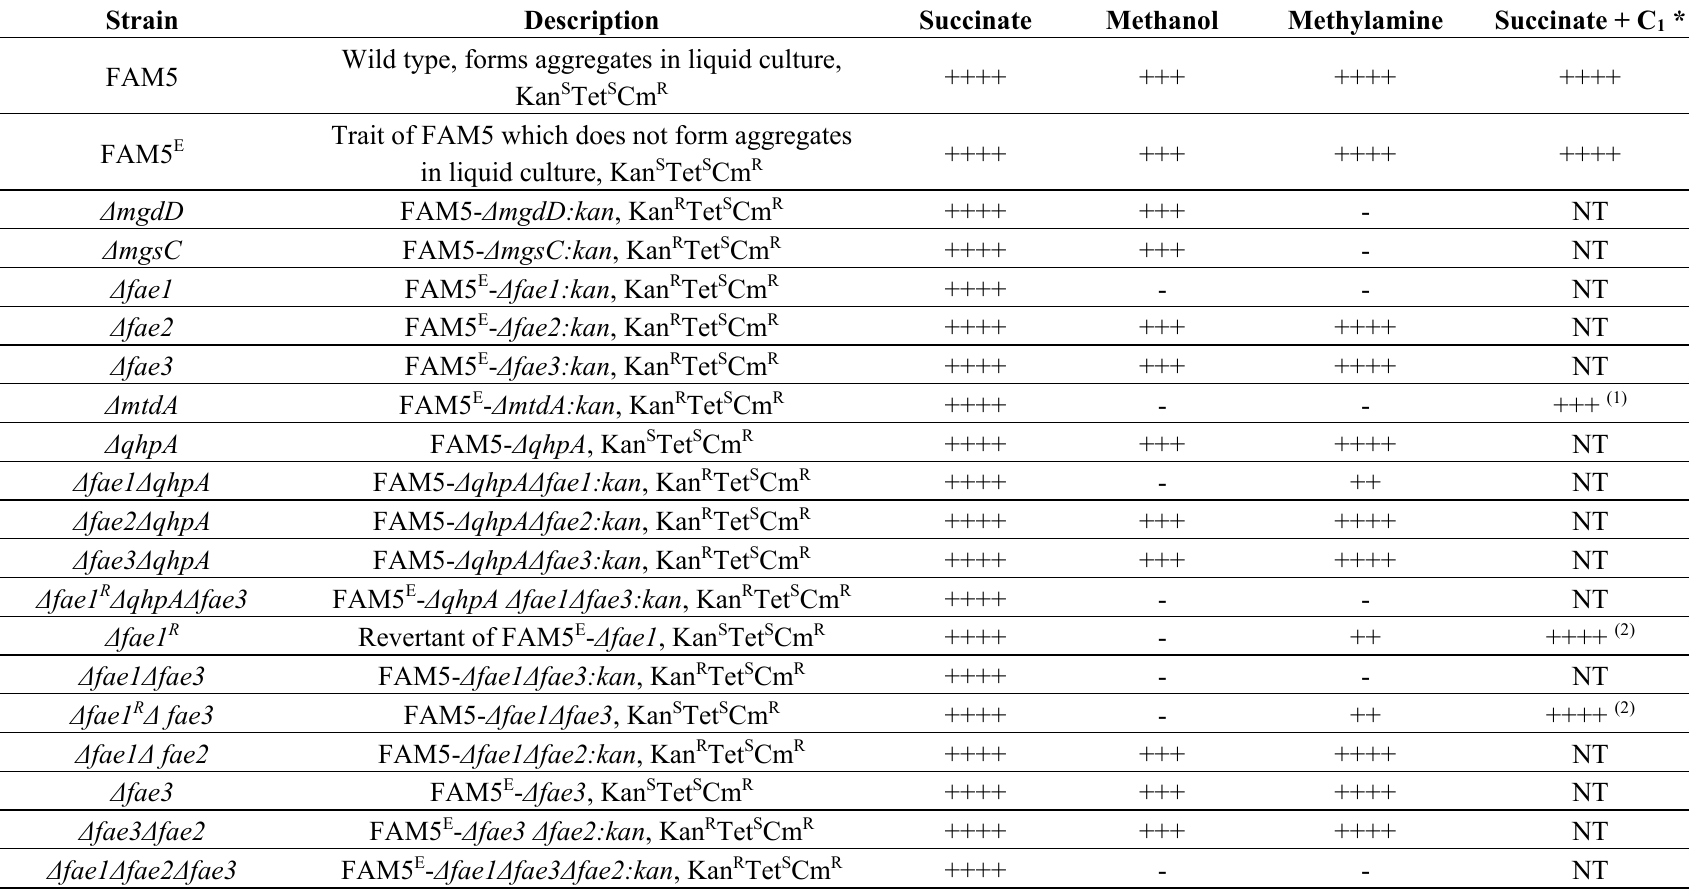
Table 1. Growth phenotypes of the Methyloversatilis universalis wild type and mutant